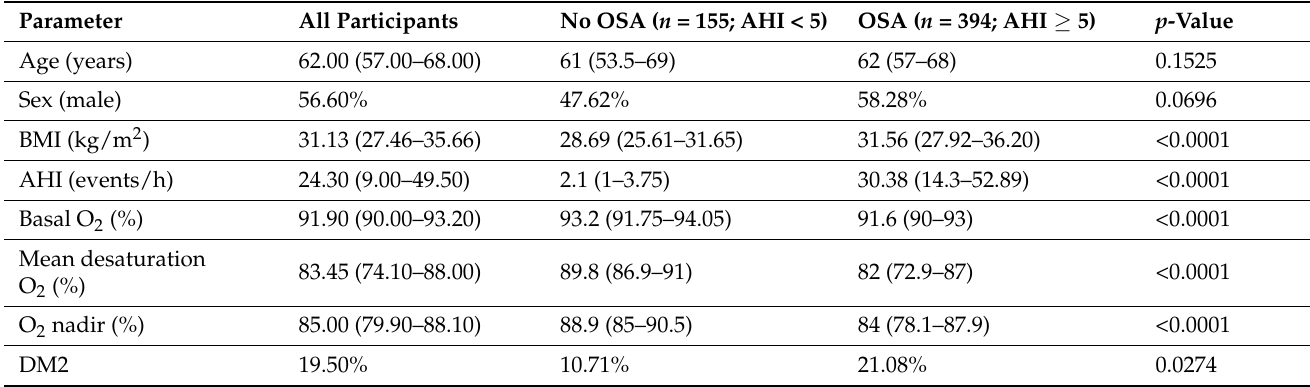
Table 1. Group characteristics.